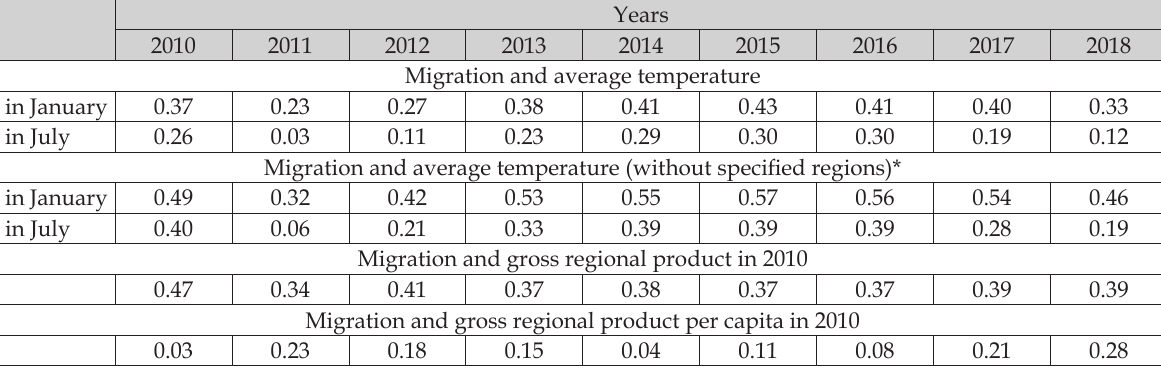
Table 1. Indicators of correlation of the migration growth coefficient by regions of Russia (in ‰) and other data under